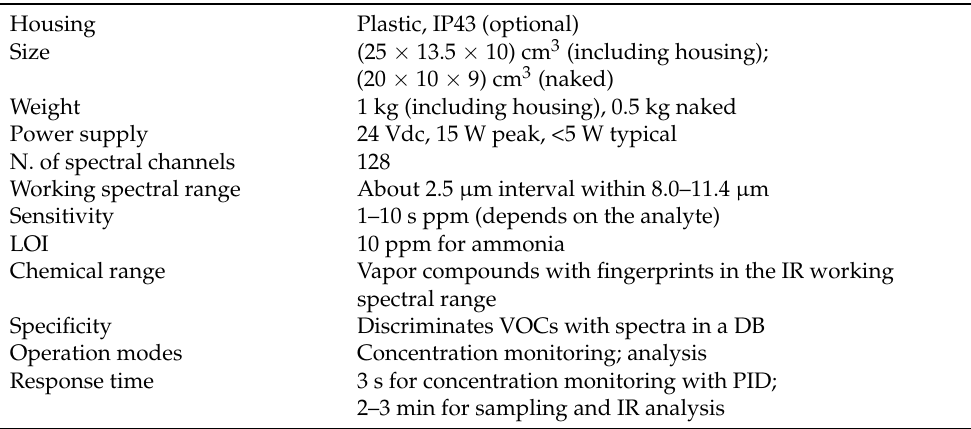
Table 1. Specifications of the lightweight C